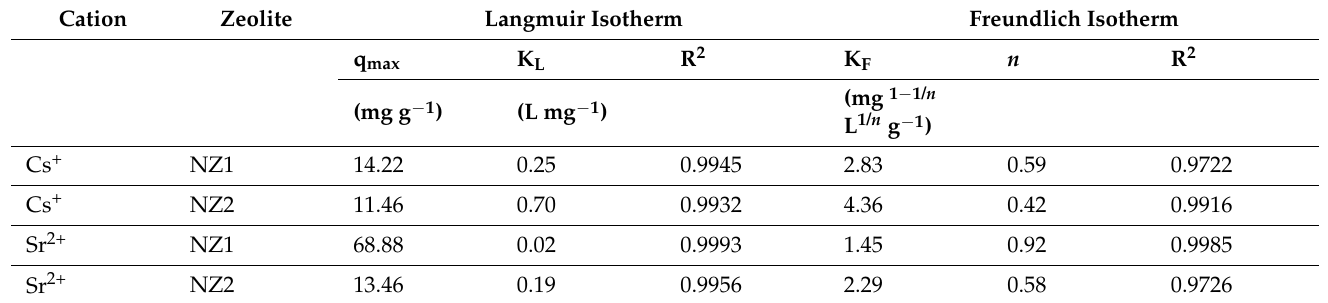
Table 3. Langmuir and Freundlich parameters for Cs + and Sr 2+ sorption on NZ1 and NZ2 at di ff erent initial concentrations.